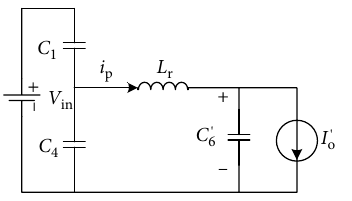
Figure 9: The equivalent circuit at (𝑡